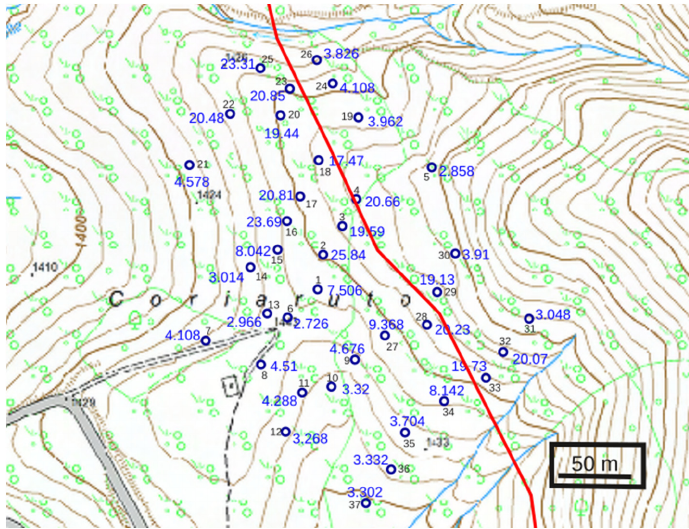
Figure 3. The map of the full set of measurements (flux values in ppm cm − 2 s − 1 ), with the fault position [43,44] shown with a red line. The x axis represents the latitude from 42°33'23.436'' N to 42°33'38.286'' N, while the y axis represents the longitude from 13°22'58.962'' E to 13°23'17.3832'' E.